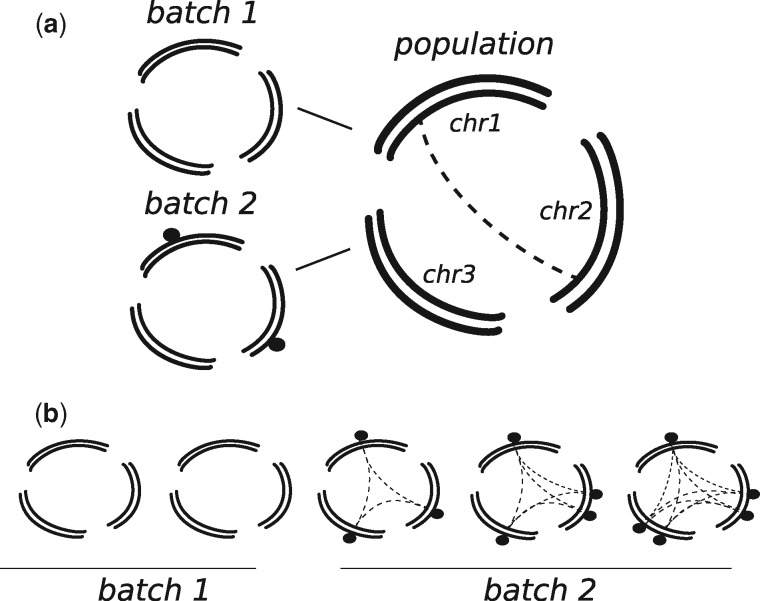
—Outline of the method. (a) Sequencing data generated from samples with different sequencing quality or processing might introduce different errors (black dots). Since these errors will be present in samples coming from the same platform, they will give a signal of linkage between different chromosomes (dashed lines). (b) The contribution to the linkage signal can be computed for each sample (dashed lines), and used to identify samples coming from the same batch and with similar error profiles, as well as the errors. See also supplementary figure 1, Supplementary Material online.